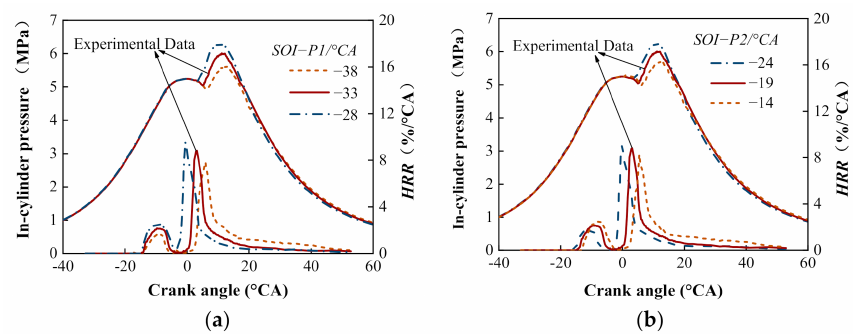
Figure 5. Pressure and HRR : ( a ) adaptation of SOI − P1 ; ( b ) adaptation of SOI − P2 .